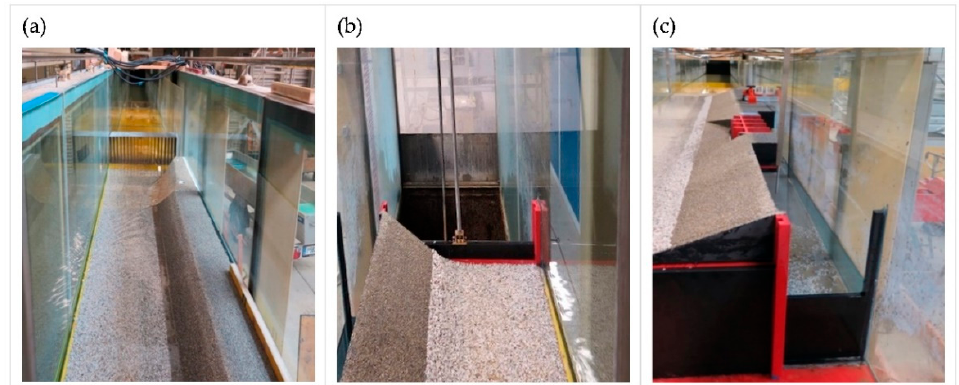
Figure 5. Physical scale model of the side weir with four weir fields in an experimental flume; rectifier at the upstream edge of the model ( a ); height-adjustable gate at the downstream edge of the model ( b ); channel collecting side weir discharge with a Poncelet weir ( c ).